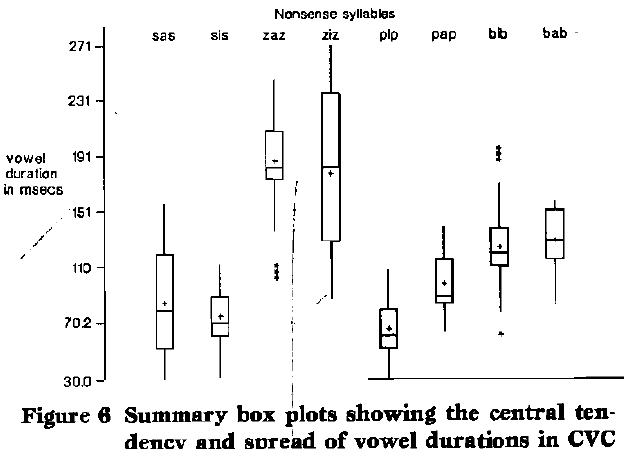
Figure β Summary box plots showing the central ten- dency and spread of vowel durations in CVC syllables in Older English speakers.